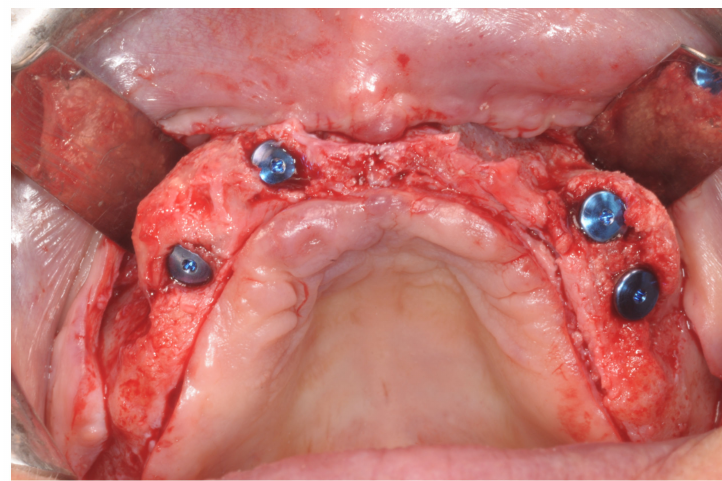
Figure 7. Placement of the dental implants.